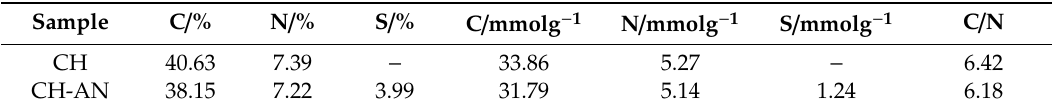
Table 1. Percentages of carbon (C) and nitrogen (N), number of moles for chitosan (CH) and chemically modified chitosan (CH-AN), and the corresponding molar ratio (C /